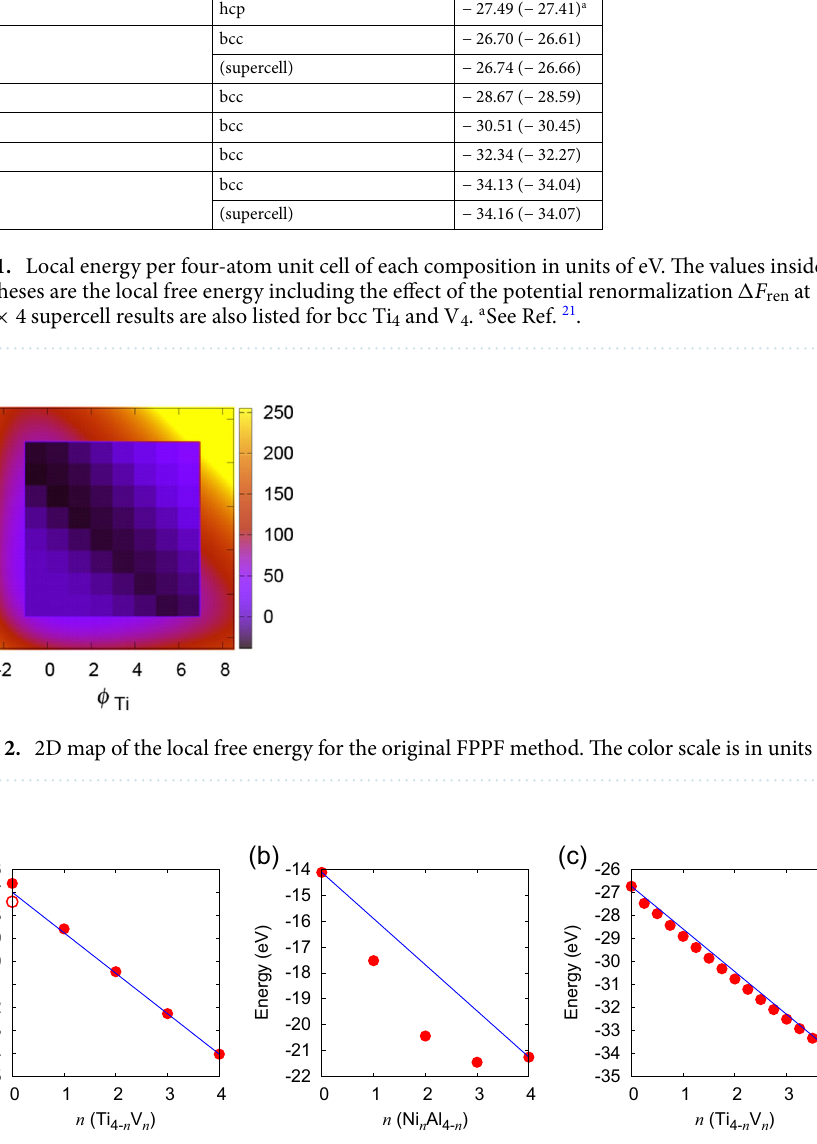
Figure 3. Plots of ( a ) the local free energy versus n of Ti 4 solid points are the energies calculated with bcc structure), ( b ) that of Ni n Al 4 versus n of Ti 4 n V n . Linear interpolation line is shown in blue −